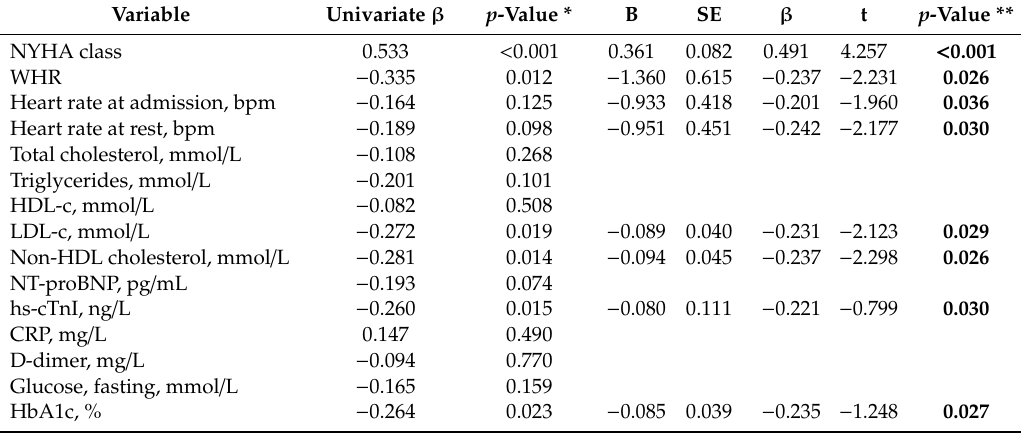
Table 4. Univariate beta estimates and results from multivariable linear regression showing associations of serum CST levels (ng / mL) with the clinical and laboratory parameters of interest.